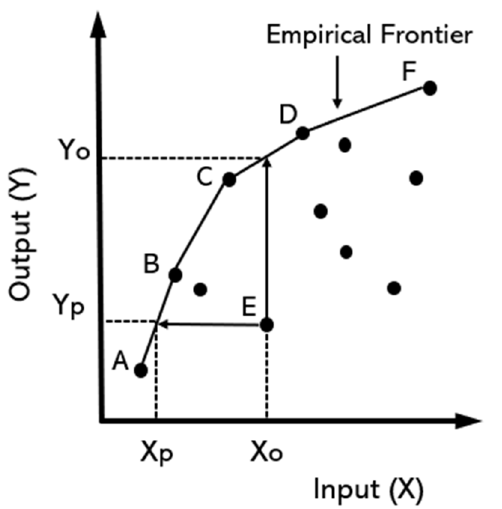
Figure 1. A graphically representation of the interpretation of DEA results.